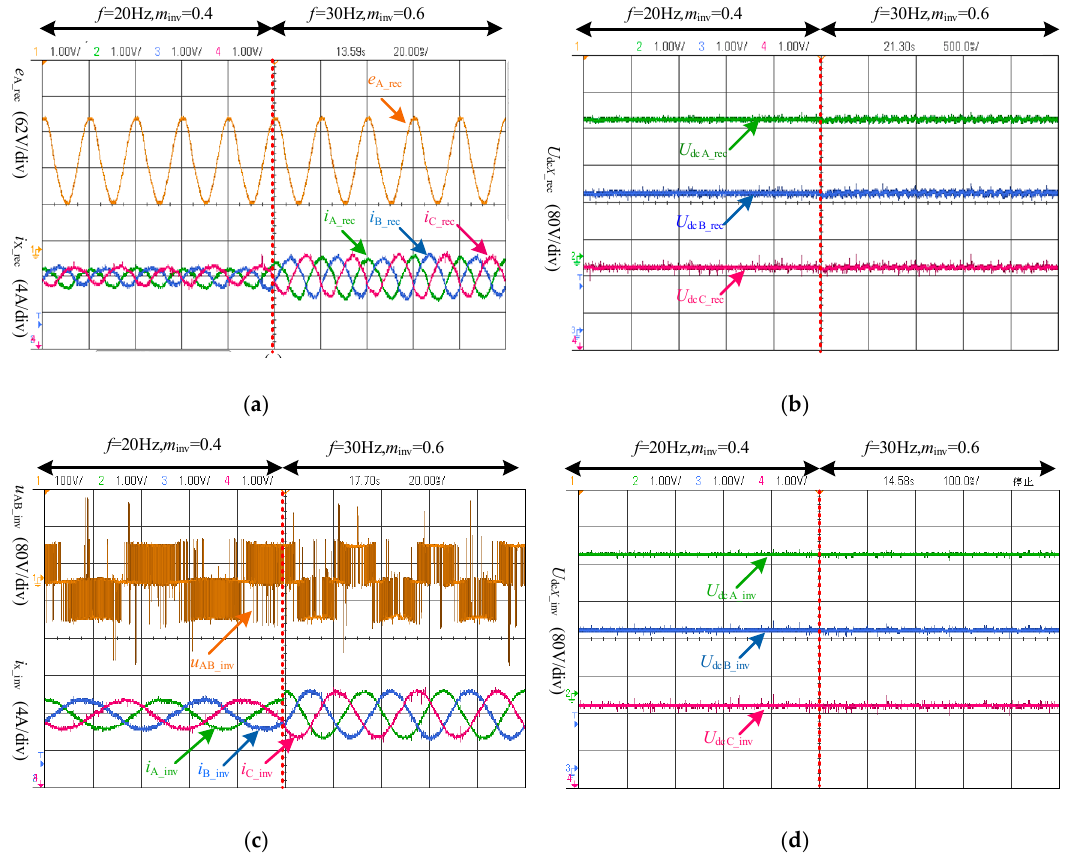
Figure 12. Experimental results of the whole working process in transient-state conditions; ( a ) Input voltage–current waveforms, e A_rec and i X _rec ; ( b ) voltages of C X _rec ; ( c ) output voltage–current waveforms, u AB_inv and i X _inv ; ( d ) voltages of C X _inv